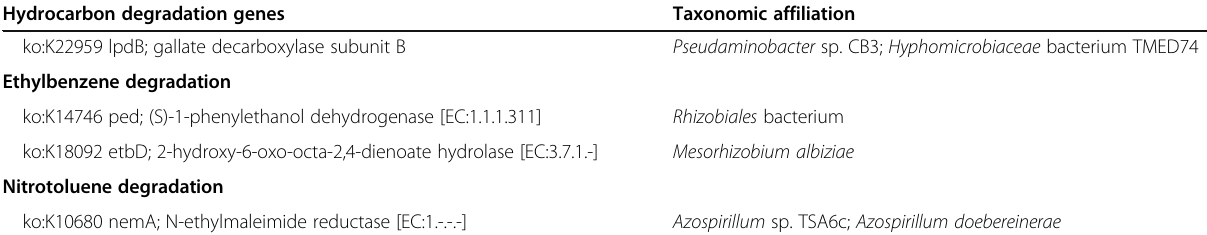
Table 2 Putative hydrocarbon degradation genes detected in the FN1 metagenome and their taxonomic affiliation (Continued) Hydrocarbon degradation genes